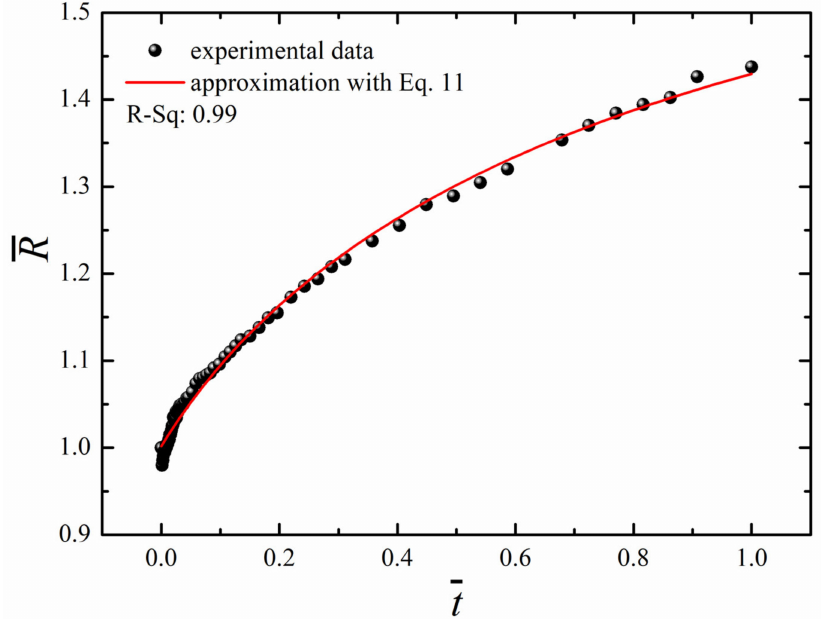
Figure 8. Time evolution of the dimensionless radius of the droplet (black circles) and its fit with Equation (11) at R 0 = 1.2 mm and τ osm = 4875